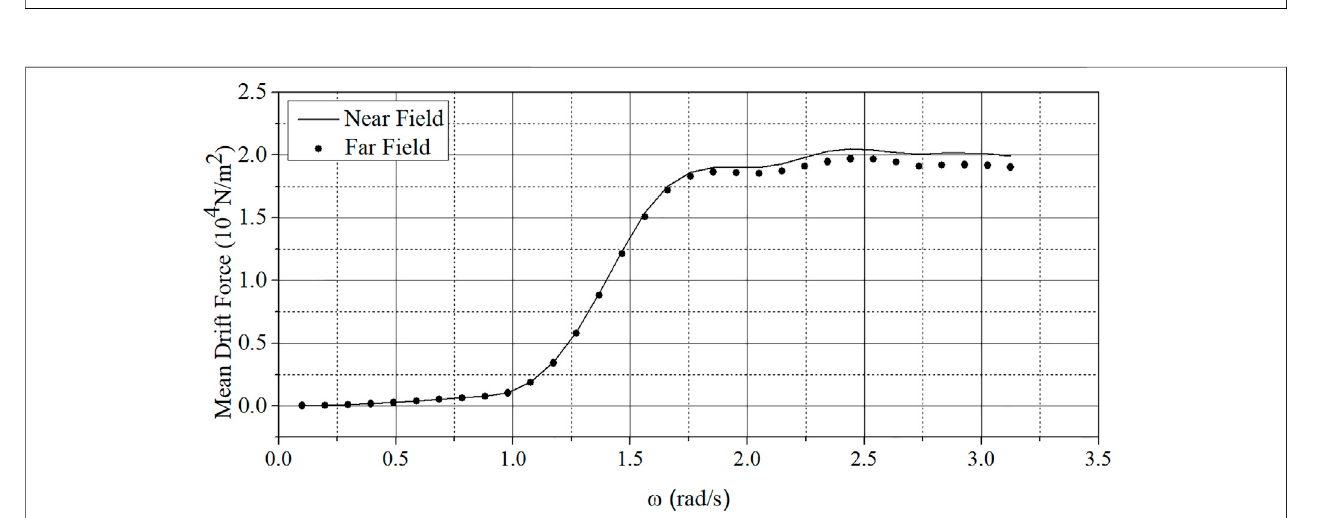
FIGURE 7 | Transfer functions of mean drift